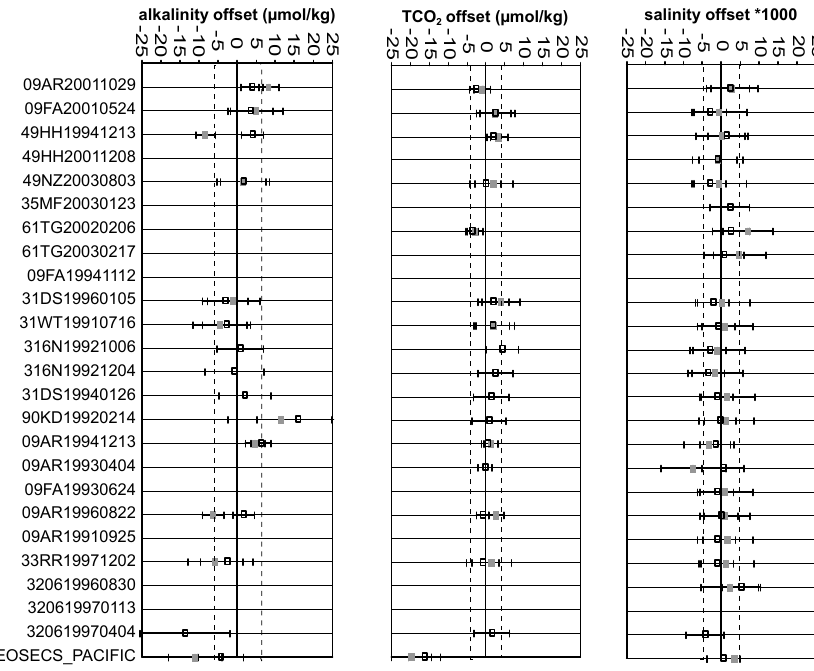
Figure 3. Results of initial inversion (grey boxes) of crossover results and for the final inversion after cruise adjustments were made (black squares) for those parameters with additive corrections. Error bars indicate one standard deviation of the inverted o ff set. The dashed lines indicate the minimum o ff sets required for an adjustment to be proposed (0.005 for salinity, 4 µ molkg − 1 for TCO 2 , 6 µ molkg − 1 for alkalinity).